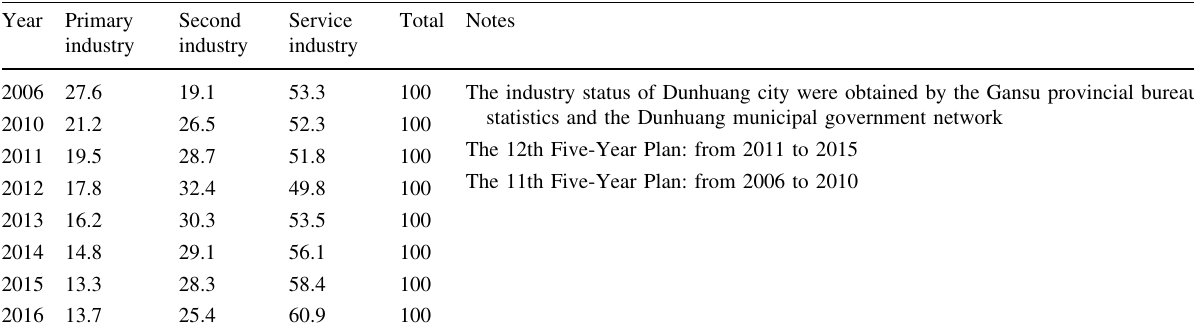
Table 6 The proportion of industry of Dunhuang city (%) Year Primary